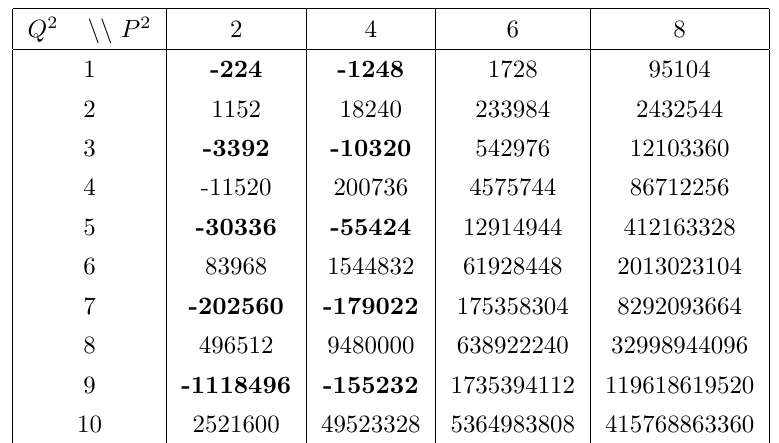
Table 16 . The index d ( Q, P ) for the Z 2 toroidal orbifold some low lying values of Q 2 , P 2 with Q · P = 0 .